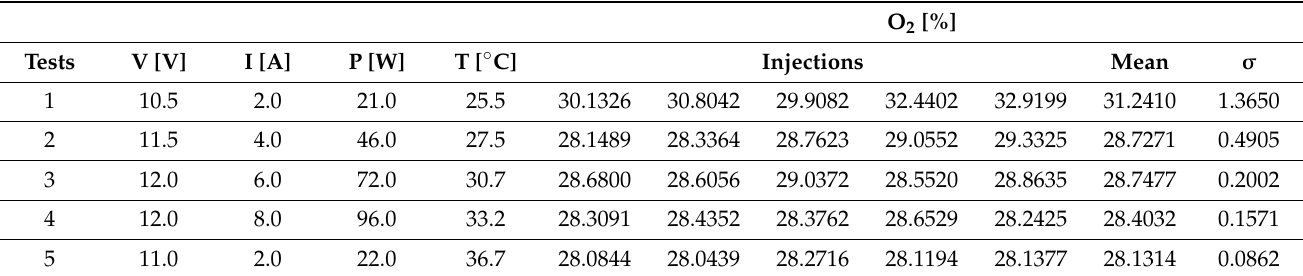
Table 6. Results of molar concentration in % of O 2 with 20% ( w/w ) of KOH.